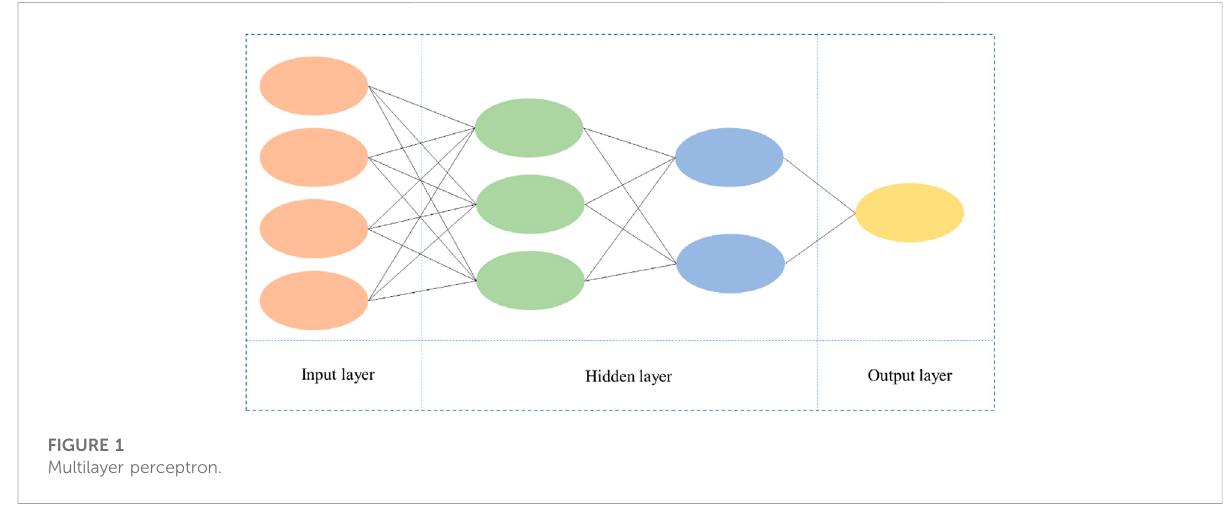
FIGURE 1 Multilayer perceptron.